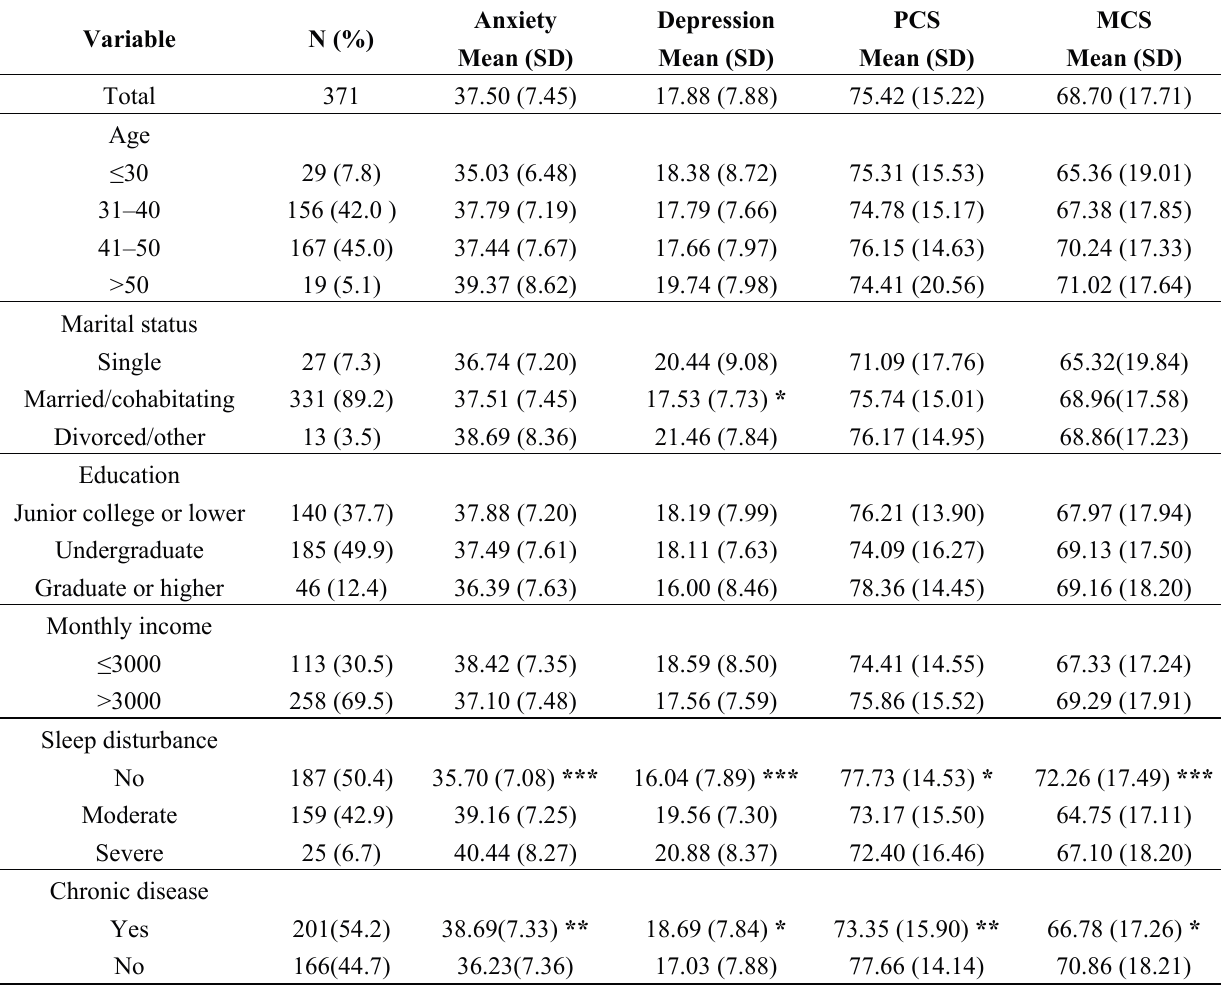
Table 1. Demographic characteristics of participants, means and standard deviations (SDs) of variables.